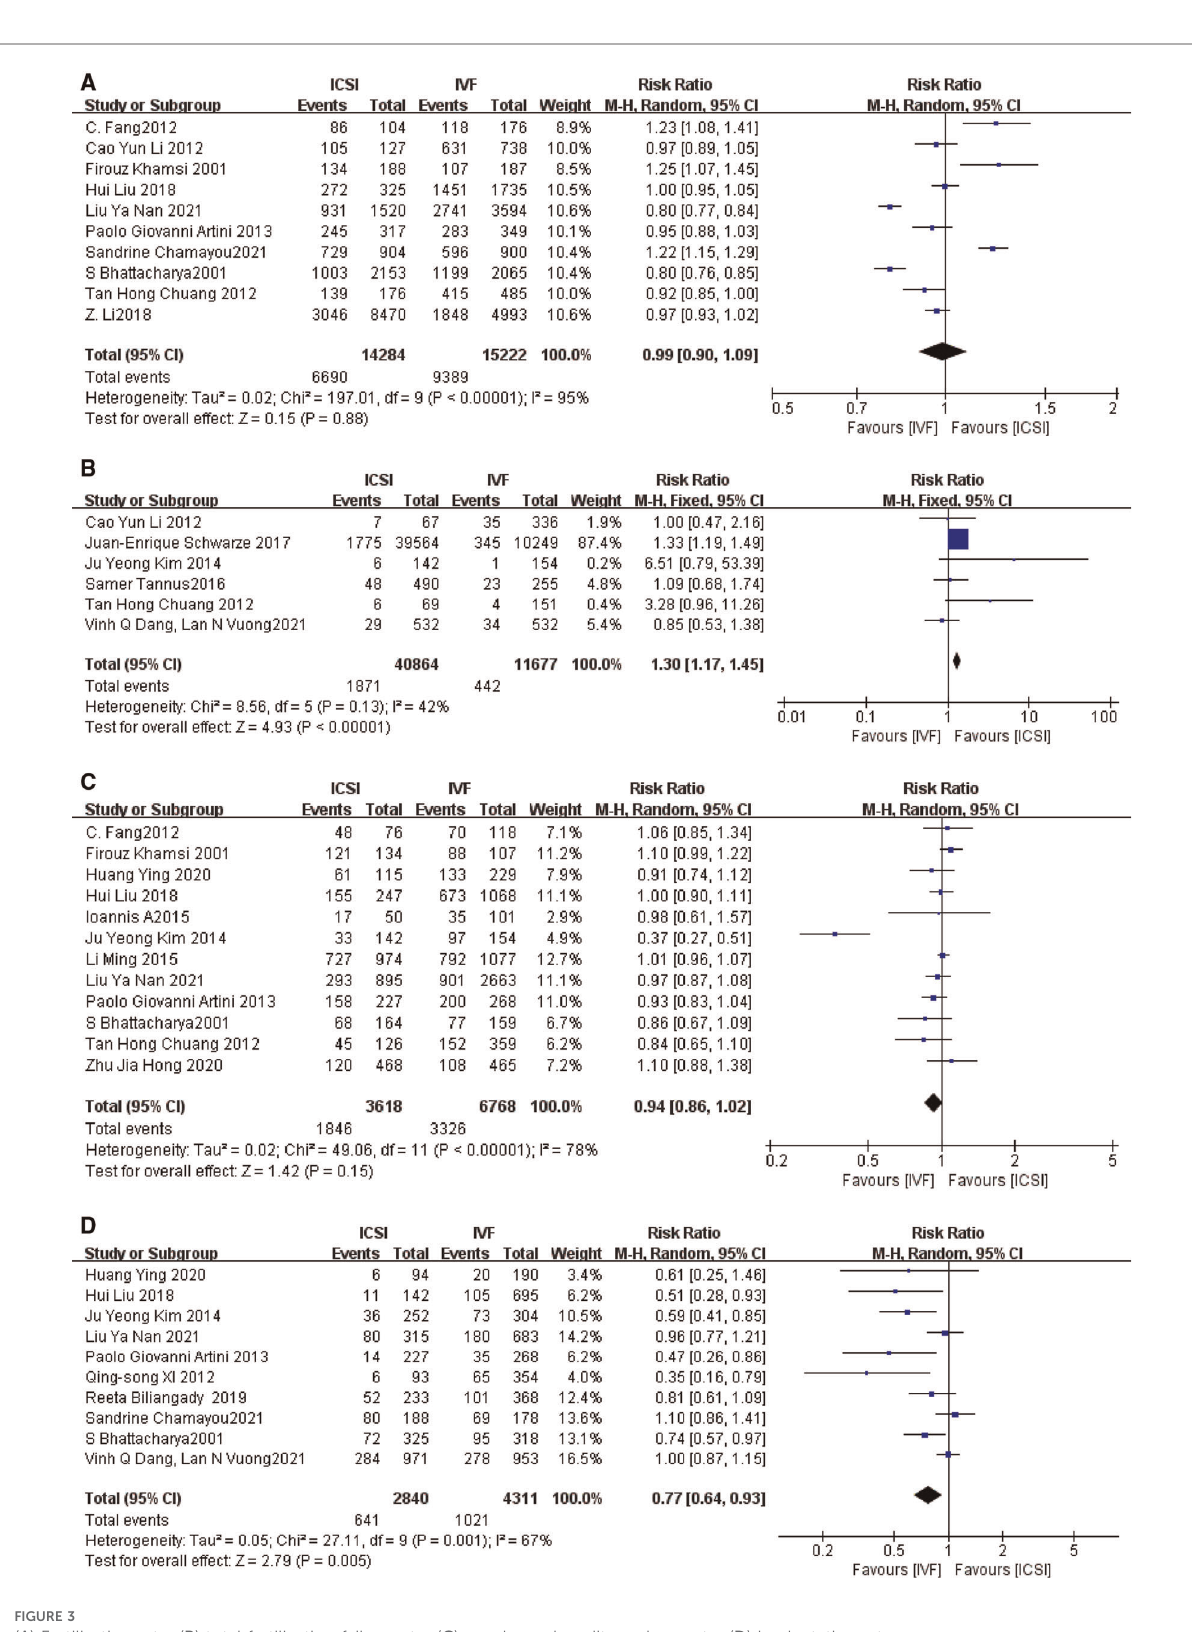
FIGURE 3 ( A ) Fertilization rate; ( B ) total fertilization failure rate; ( C ) good-good quality embryo rate; ( D ) implantation